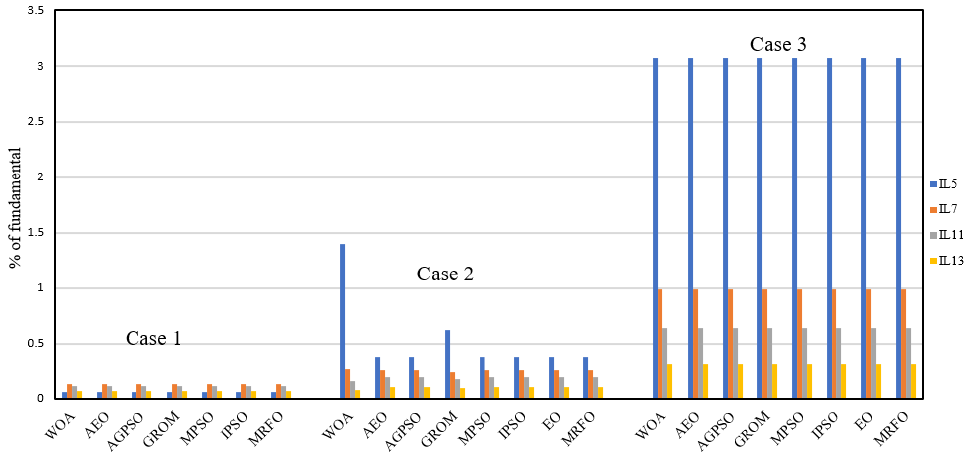
Figure 5. The individual current harmonics for configuration 1 of HAPF under the proposed three cases.